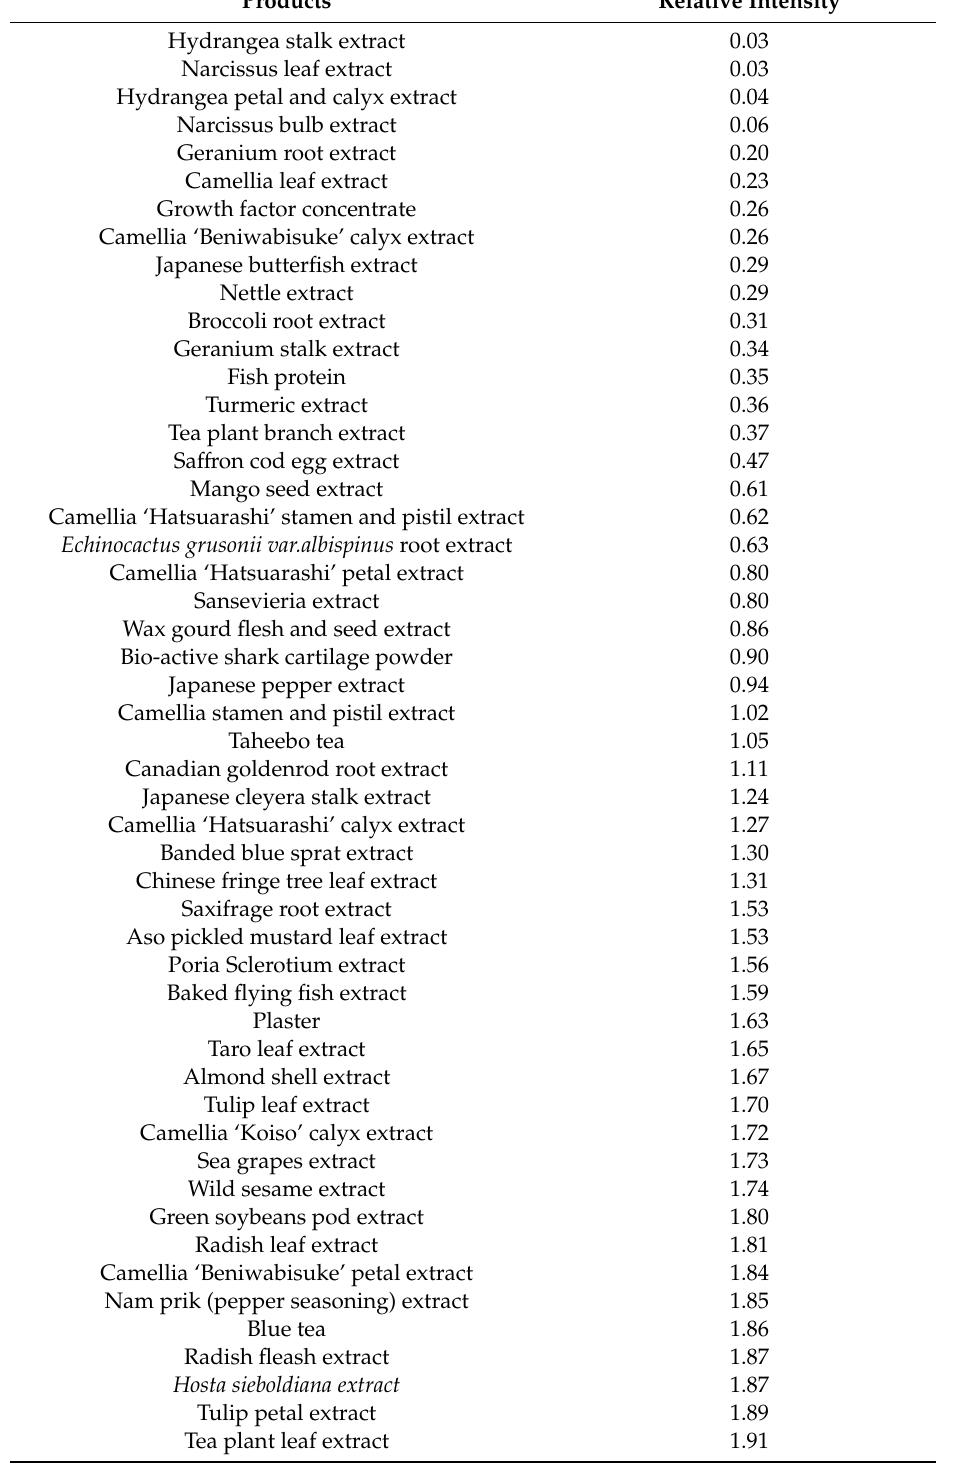
Table A1. The list of natural compounds used for the in vitro screening assay and the relative fold change of HIF activity induced by CoCl 2 administration. *Positive control